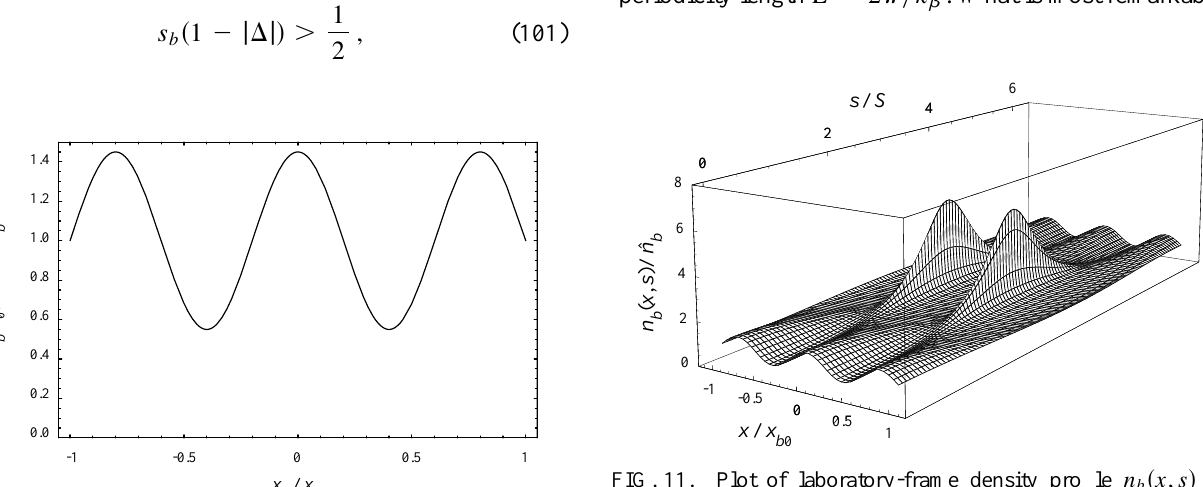
x b (cid:1) s (cid:2) . Of course, as a function of s , the density profile n b (cid:1) x , s 1 L (cid:2) (cid:1) n b (cid:1) x , s (cid:2) is periodic, with fundamental